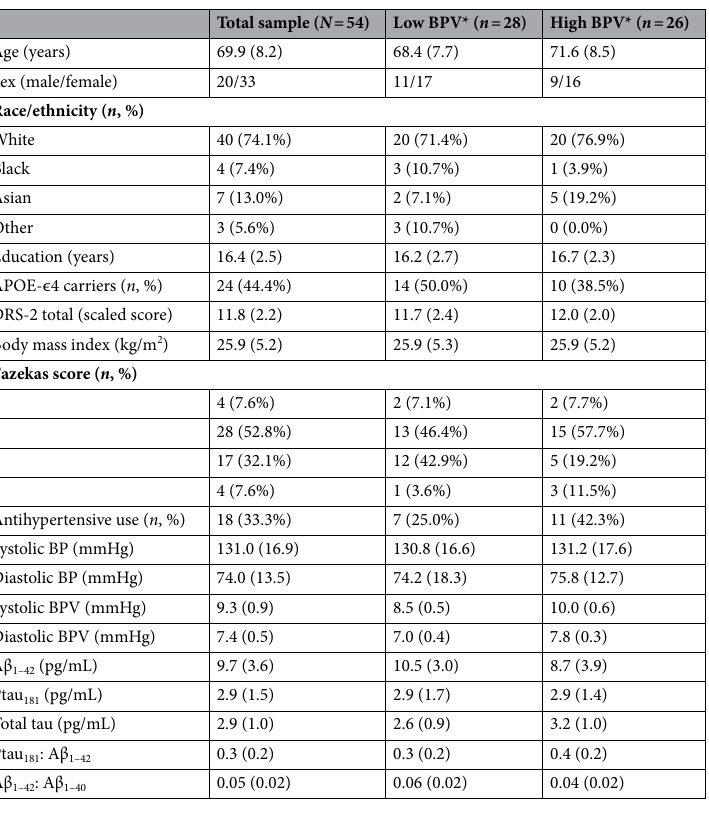
Table 1. Demographic and clinical information. Means and SDs shown unless otherwise indicated. APOE e4 apolipoprotein e4, DRS-2 Dementia Rating Scale-second edition, BP blood pressure, BPV blood pressure variability, Ptau 181 phosphorylated tau. *Low/high BPV calculated as below/above the mean BPV from the overall